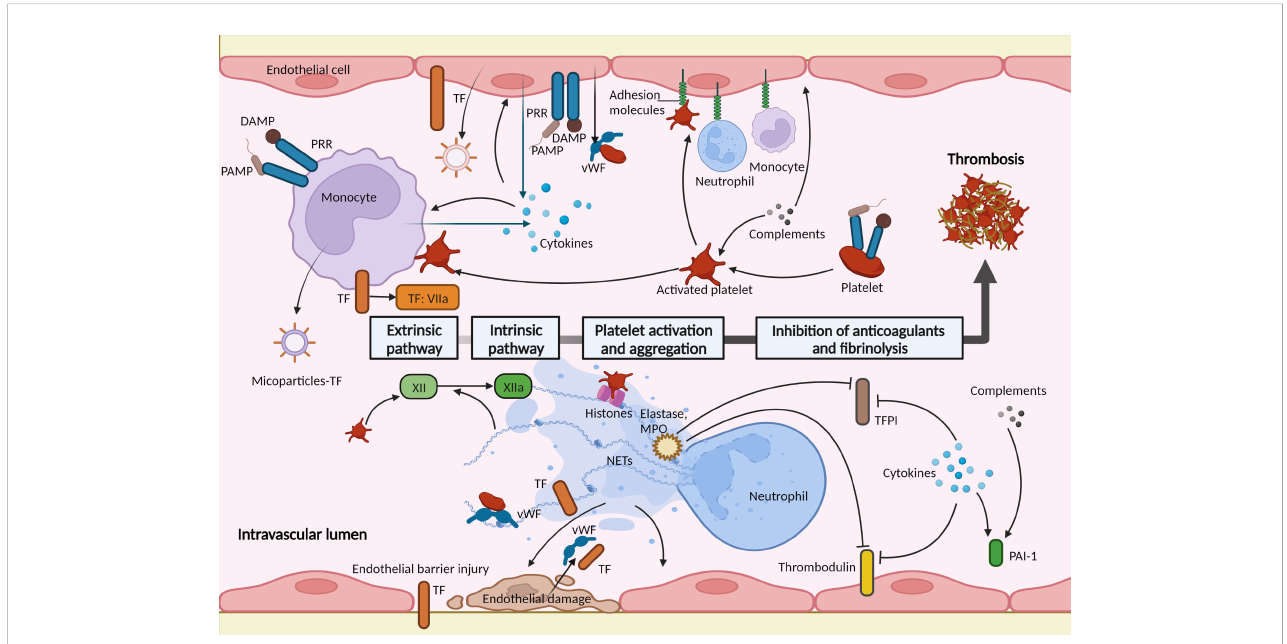
FIGURE 2 Immune-related factors in hemostasis activation during sepsis. Activation of the coagulation pathway, platelet activation and aggregation, and impaired anticoagulant and fi brinolytic pathways act cumulatively to a procoagulant state in sepsis. These are mediated by multiple immune-related molecular and cellular factors. Monocytes and endothelial cells play important roles in thrombus formation during sepsis. They express and release tissue factor (TF) when recognizing pathogen-associated molecular patterns (PAMPs) or damage-associated molecular patterns (DAMPs) through pattern recognition receptors (PRRs). The activated endothelial cells serve as a bridge between the coagulation response and immune factors. Endothelial cells expressed adhesion molecules (such as E-selectin and intercellular adhesion molecule 1) mediating the adhesion and interactions of immune cells. The injured endothelial barrier loses antithrombotic function and induces exposure of TF; the damaged endothelial cells release prothrombotic molecules, such as von Willebrand factor (vWF) and TF. Platelets are activated and interact with circulating leukocytes and endothelial cells, and trigger factor XII initiating the intrinsic coagulation pathway. Neutrophil extracellular traps (NETs), released by neutrophils, support immunothrombosis in several ways: activate and damage endothelial cells; NETs and histones in NETs promote the recruitment and activation of platelets; bind to TF and activate factor XII; neutrophil elastase and myeloperoxidase (MPO) in NETs inhibit the anticoagulants. Activated complements activate endothelial cells and platelets and increase the level of plasminogen activator inhibitor-1 (PAI-1). Proin fl ammatory cytokines increase the expression of TF in monocytes and endothelial cells; activate leukocytes, platelets, and endothelial cells; downregulate anticoagulants and fi brinolysis pathways. TFPI, tissue factor pathway